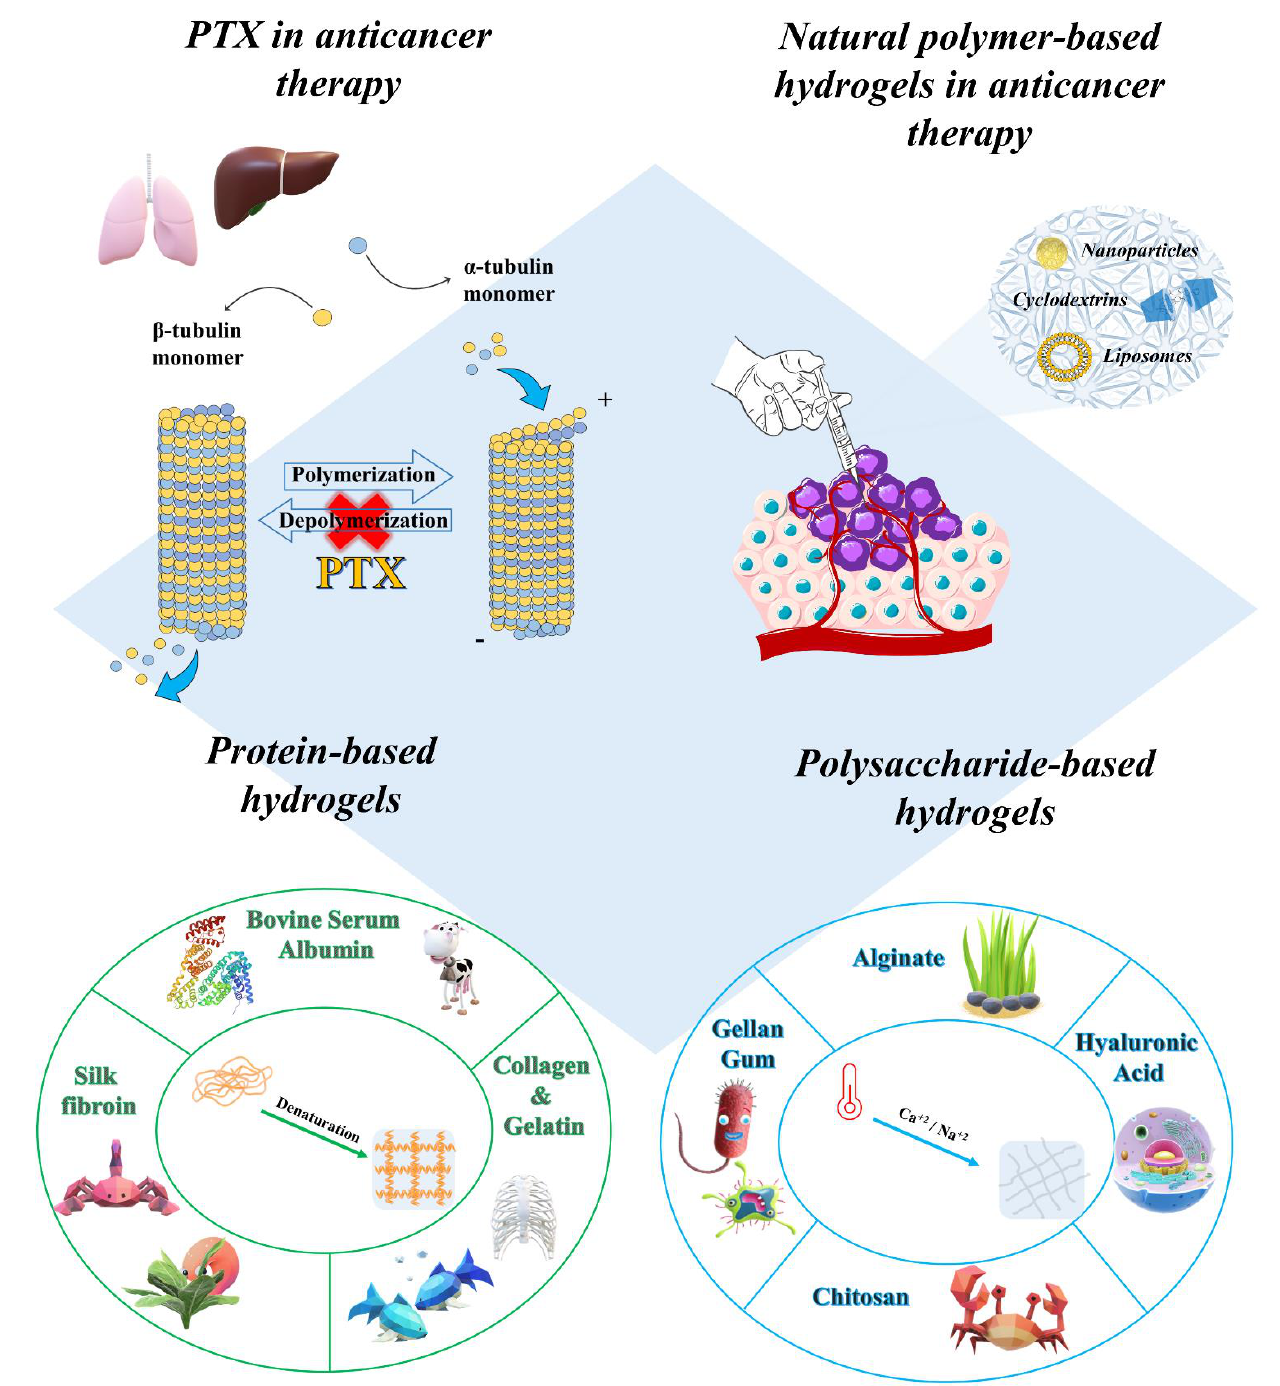
Figure 2. Graphical representation of the area covered in the